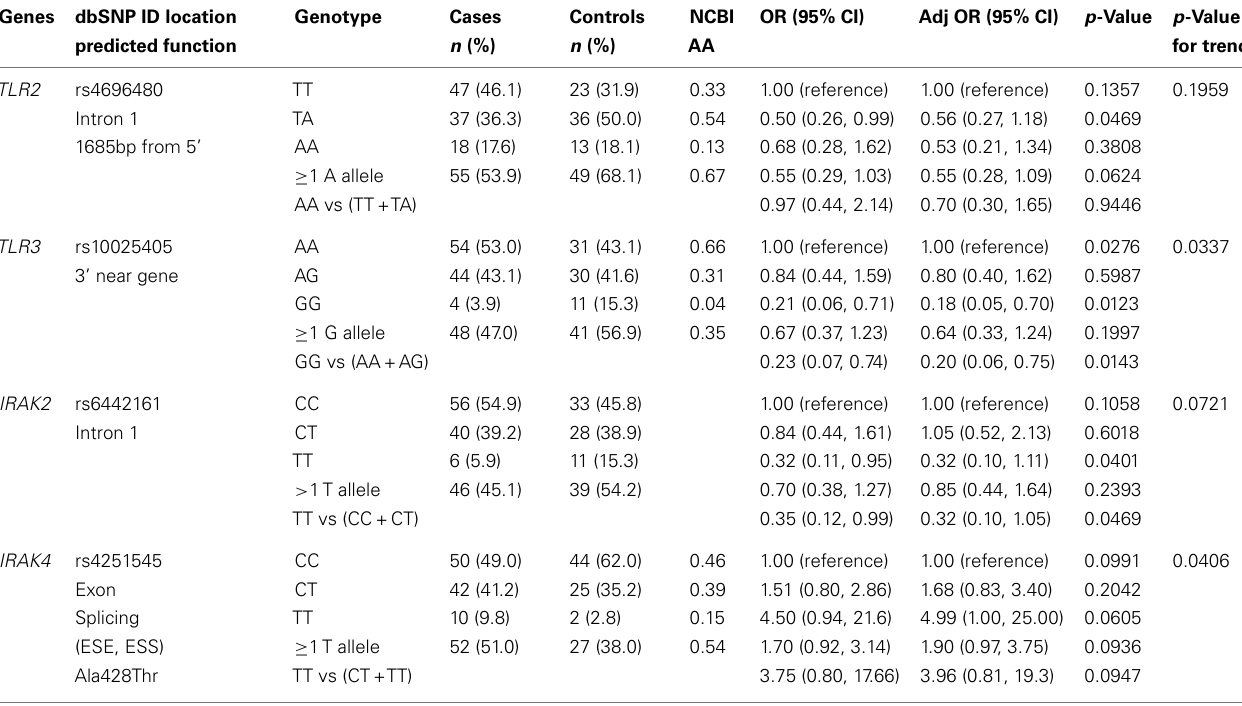
Table 3 | Innate immune SNPs associated with BrCa risk amongAfrican-American women. Genes dbSNP ID